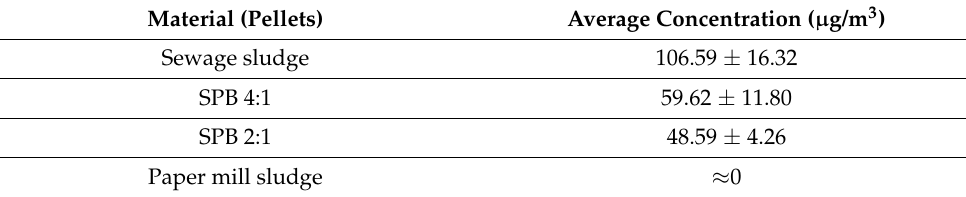
Figure 3. Steady state temperature profile in the fluidized bed reactor at various fuel combustions. Table 3. Average concentration of mercury in the flue